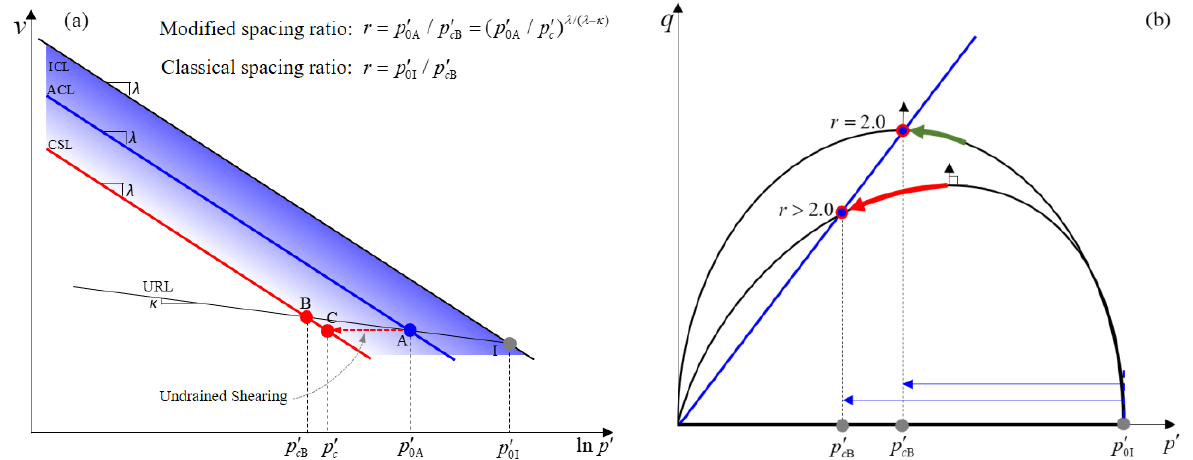
Figure 1. Spacing ratio of soil in ( a ) v -ln p ’ plane and ( b ) p ’- q plane (ICL is the isotropic consolidation line, ACL is the anisotropic consolidation line, CSL is the critical state line, URL is the unloading- reloading line, v is the specific volume 1 + e ). (Modified from Figure 3 in the literature [30]).